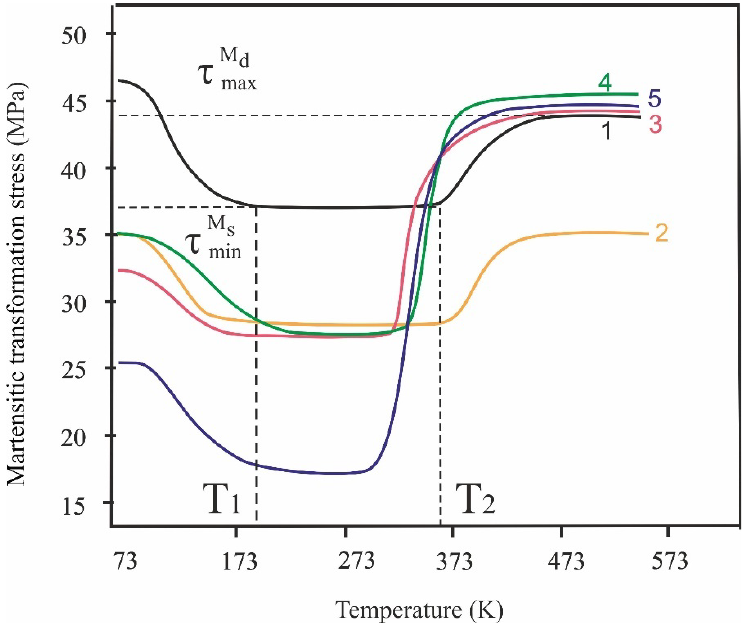
Figure 6. Temperature dependence of martensitic transformation stresses: 1—TiNi, 2—TiNiCu 1 , 3—TiNiCu 3 , 4—TiNiCu 6 , 5—TiNiCu 10 .